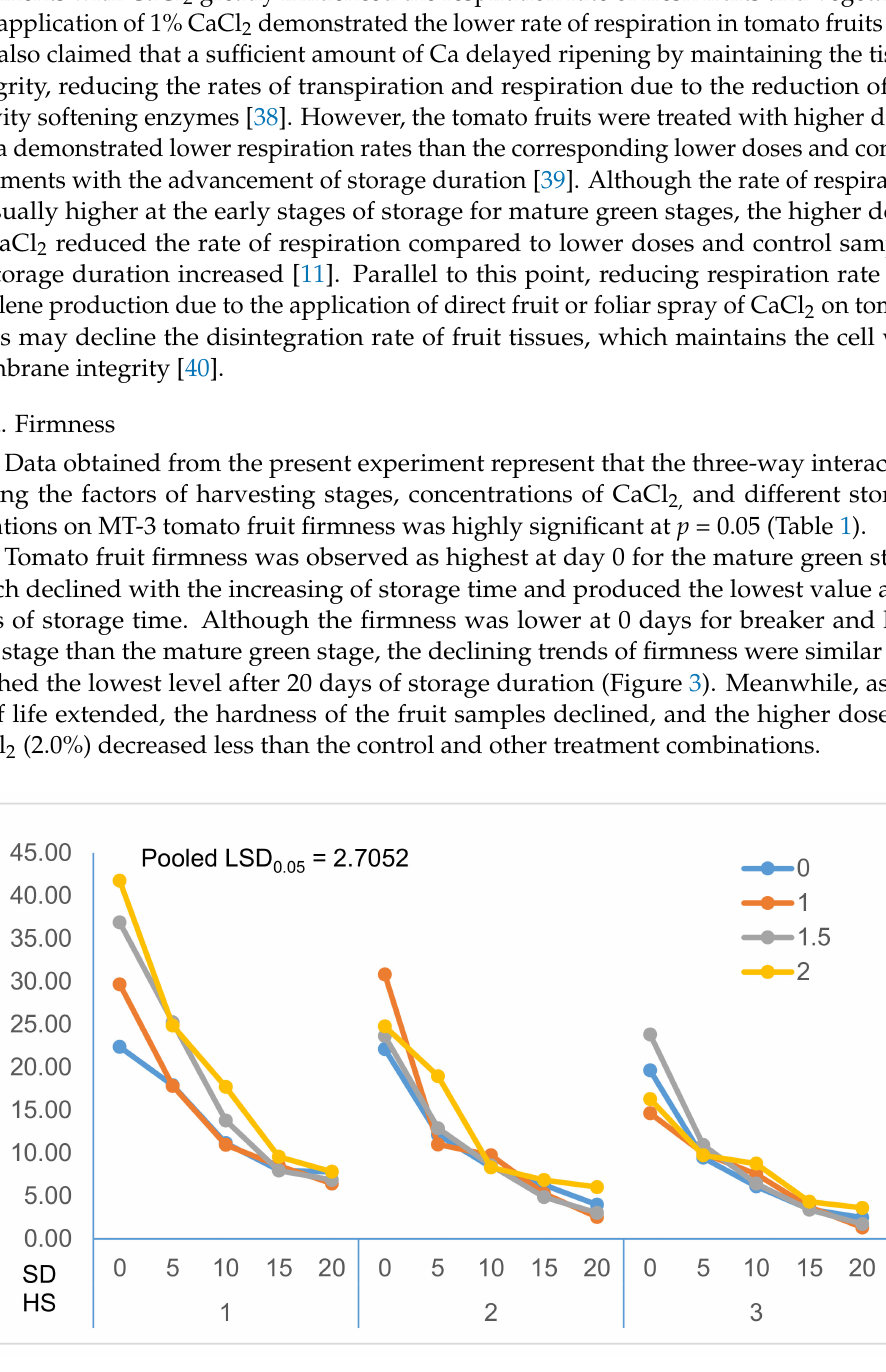
Figure 3. The interaction effects of CaCl 2 (0, 1%, 1.5%, and 2%, w / v ), harvesting stages (HS: 1 = green mature, 2 = breaker and 3 = half ripe) and storage durations (SD: 0, 5, 10, 15 and 20 days) on the tomato fruit firmness stored at ambient temperature (28 ± 2 ◦ C and 75 ± 5% RH). Pooled LSD 0.05 =